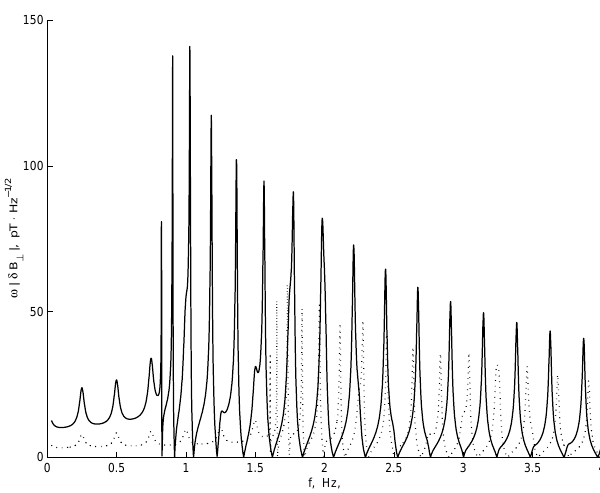
Fig. 7. Dependence of the nighttime power spectrum at the ground level on the ground conductivity. The solid line 1 corresponds to σ g = 0 and the dashed line 2 corresponds to σ g = 10 − 2